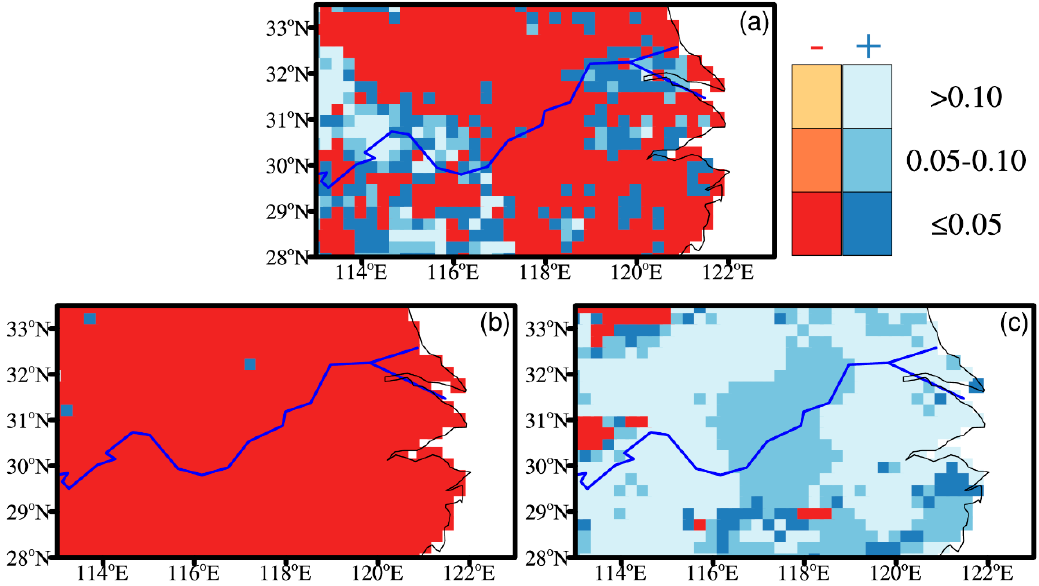
Figure 6. Relationship between summertime precipitation events associated with tropical cyclones (TCs) and El Niño–Southern Oscillation (ENSO) in preceding winter, regression coefficients derived from Poisson regression display at different level of significance. ( a ) Normal rainfall events. ( b ) 75th percentile precipitation events. ( c ) 95th percentile precipitation events. The bold blue curve denotes the Yangtze River.